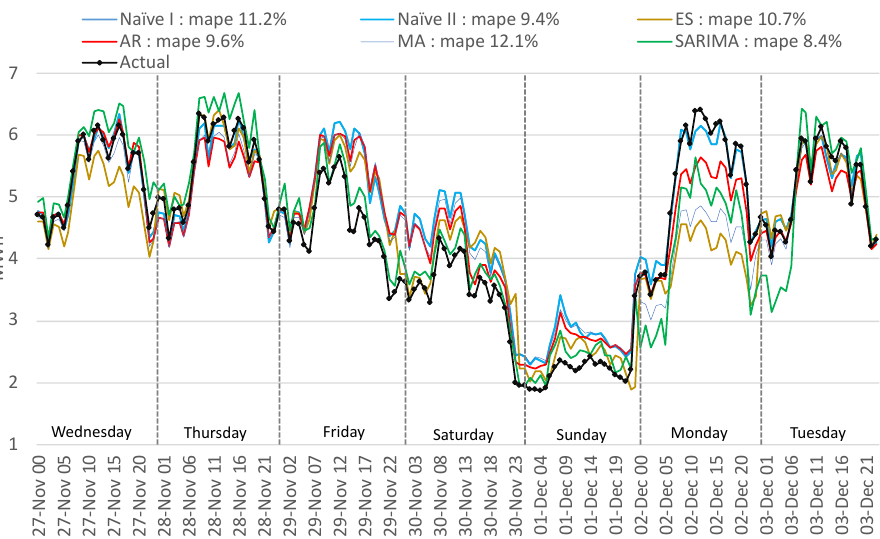
Figure 16. Comparison of actual with forecasted consumption—traditional